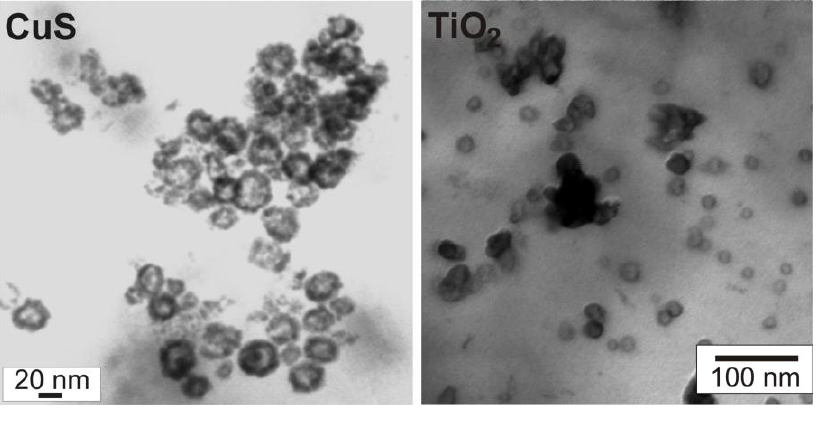
Figure 12. Scanning transmission electron microscopy (STEM) of CuS and TiO spheres